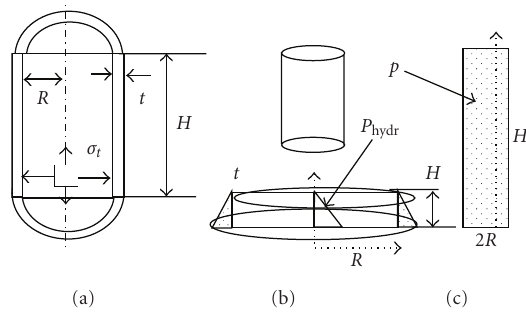
Figure 2: (a) The case study model. Resulting geometry of analyti- cal solution. (b) Hydrostatic pressure gives a flat vessel H/R = 1 / 2. (c) Even pressure gives a long pipe, H (cid:2) R